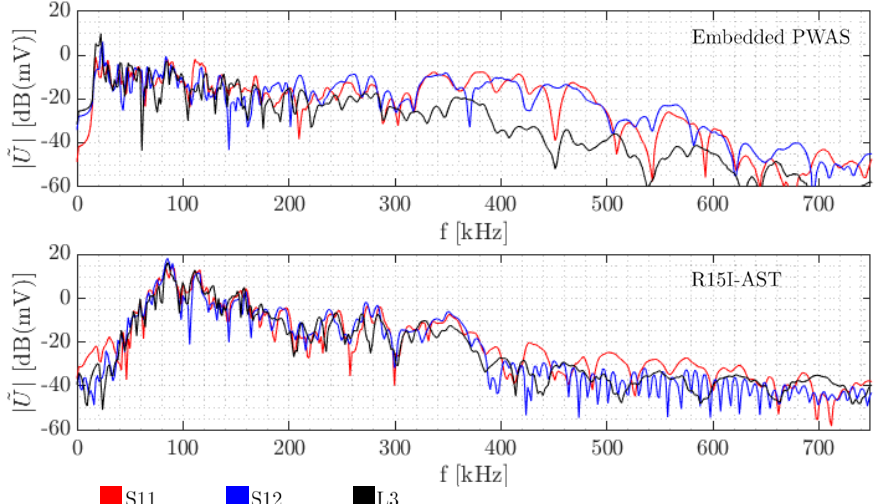
Figure 5. Typical amplitude spectrum of Hsu ‐ Nielsen sources as recorded by the small and large embedded PWAS and the surface ‐ mounted sensor.